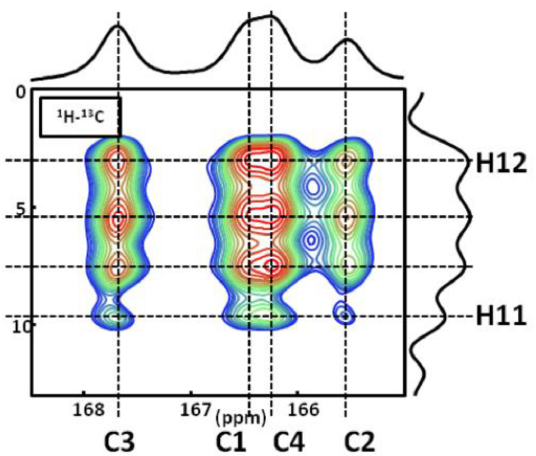
Figure A2. 1 H − 13 C CP DNP HETCOR MAS NMR spectrum of COM at T = 100K. In total, four distinct 1 H resonances are clearly evidenced on the 1 H indirect dimension. The contact time is 9.0ms, and 16 1 H / 13 C correlations are observed. Note: the temperature used (100K) has an impact on the values of the 13 C chemical shifts. The main goal here is to demonstrate that four 1 H resonances are clearly observed in the indirect